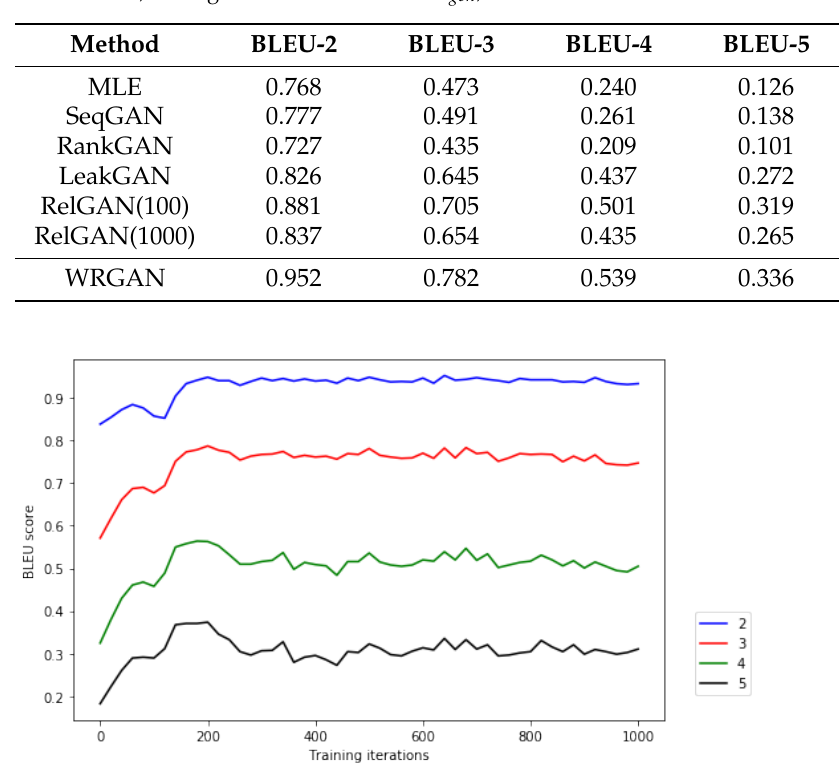
Table 3. The BLEU and NLL scores on EMNLP 2017 WMT News with Dimension = 256. For the BLEU scores, the higher the better. For NLL gen , the lower the better.